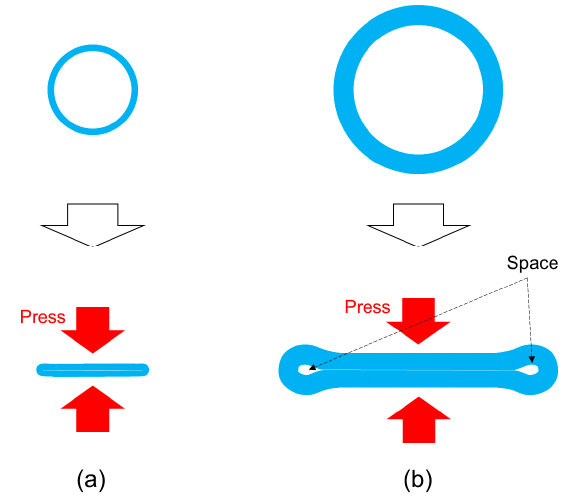
Figure 9. Schematic illustrations showing the shapes of the collapsed tubes. ( a ) When the small diameter tube which was used for the s-FRP and the s-MRP was loaded with a certain pressing force by the roller, the tube became completely flat, and there was no space for solution flow. ( b ) When the large diameter tube was loaded with a certain pressing force, there were some spaces for solution flow with the l-MRP and the PP.